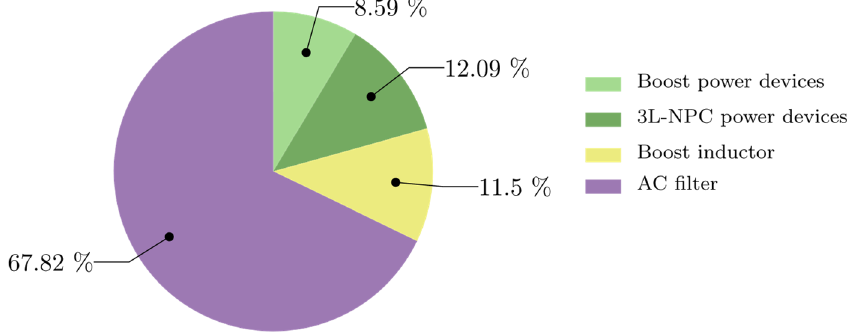
Figure 11. Relationship between the irradiation level and the RMS of the leakage current for both controllers.